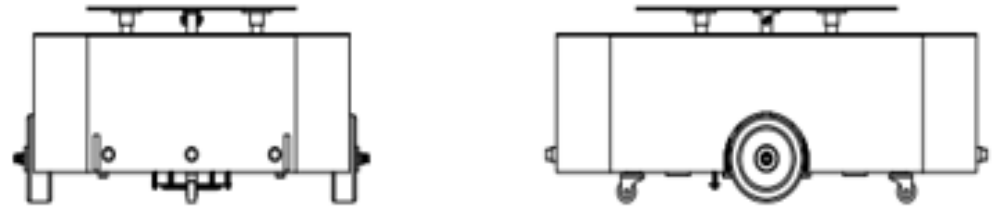
Figure 1. Computer-aided design for autonomous grounded robot (AGR) ( left : front side of robot, right : side view of robot).